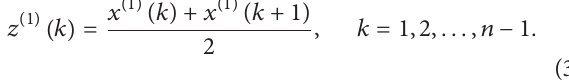
prediction result can be obtained under limited data